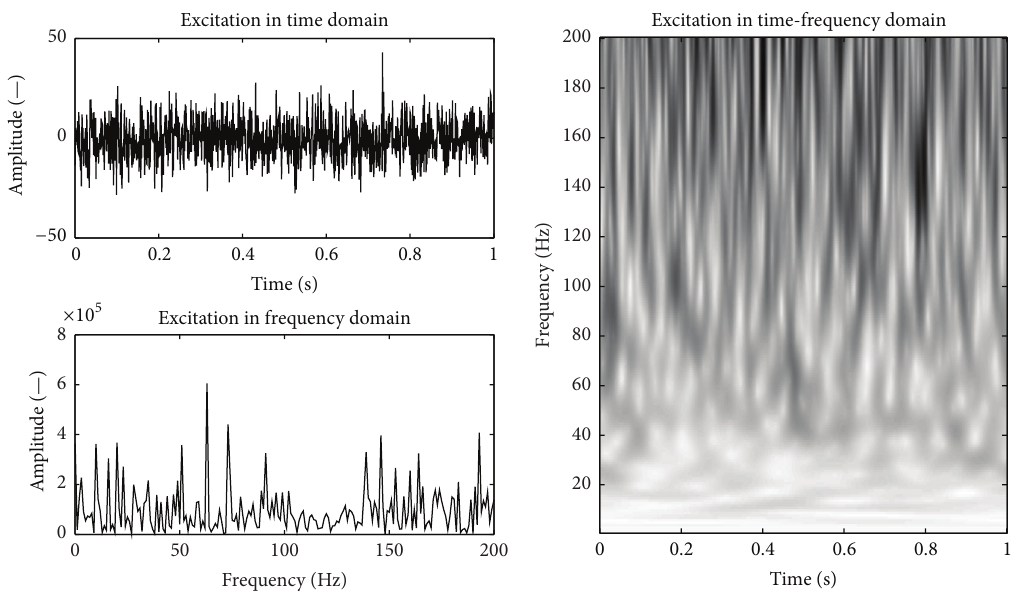
Figure 4: White noise excitation given in the time, frequency, and combined time-frequency